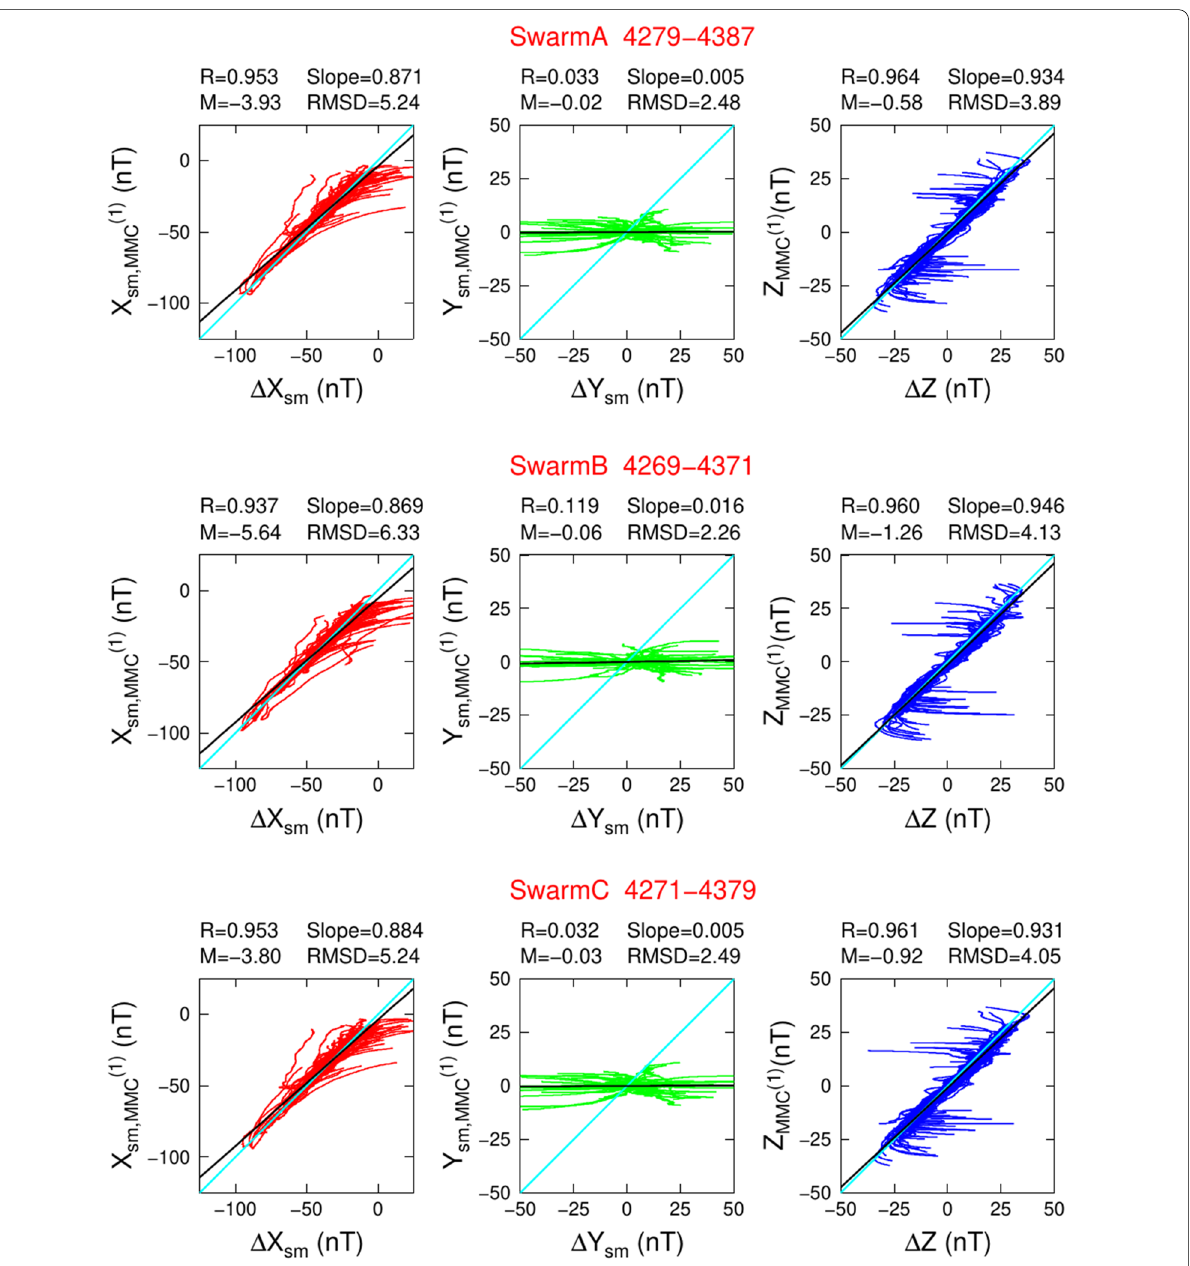
Fig. 5 The same as Figs. 1 and 2, but for the magnetic field components X ( 1 ) sm,MMC , Y ( 1 ) sm,MMC and Z ( 1 ) MMC due to the two-circular loop model of MRCs and MICs, and spherical magnetic field residuals (cid:31) X sm , (cid:31) Y sm and (cid:31) Z . The magnetic fields of PEJs and FACs have not been removed from Swarm magnetic